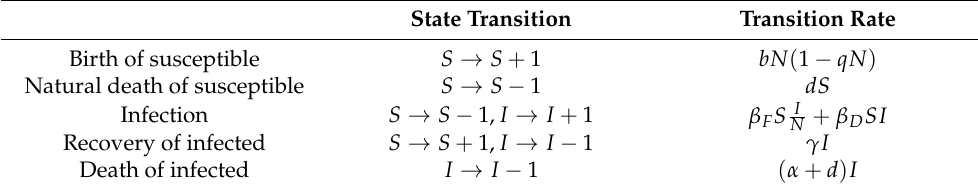
Table 1. Possible events and their respective state transitions and transition rates for the stochastic representation of an SIS model framework. Model parameters are defined in the main text. Note, the transition rate for the birth of a susceptible is set to zero if qN >